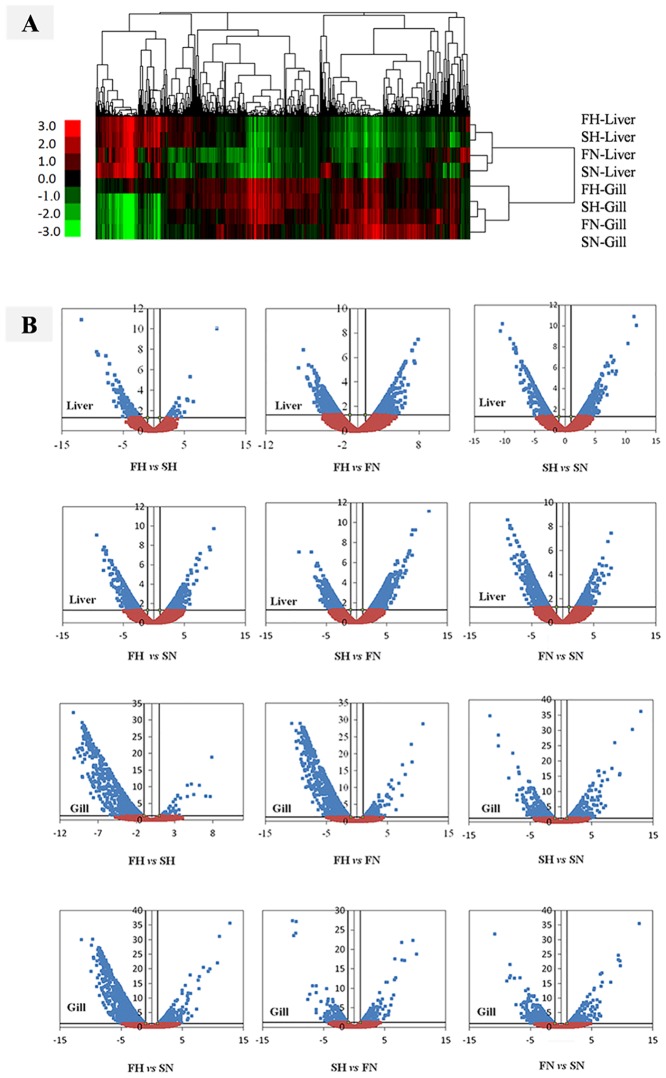
Analysis of differentially expressed genes in the blunt snout bream.(A) Clusters of differentially expressed genes in the liver and gills of the blunt snout bream from four groups, as shown in Table 1. Expression changes and cluster analysis of 6,639 genes that were differentially expressed between any two tissue samples. Each column represents a differentially expressed gene, and each row represents a sample. Changes in expression levels are shown using color scales with saturation at >2-fold changes. Green and red gradients indicate a decrease and increase in transcript abundance, respectively. Clustering was performed using the Pearson distance method, and hierarchical clustering, pairwise centroid–linkage. (B) DE gene analysis and volcano plot for 12 comparative groups. The x-axis is the value of Log2 (Fold Change), and the y-axis is the value of–Log10 (p-value). Vertical lines are boundaries of difference threshold of 2-fold change, and the horizontal line is p<0.05. The blue dots present differential expression genes that meet the requirements, while the orange dots present differential expression genes that do not meet the requirements.